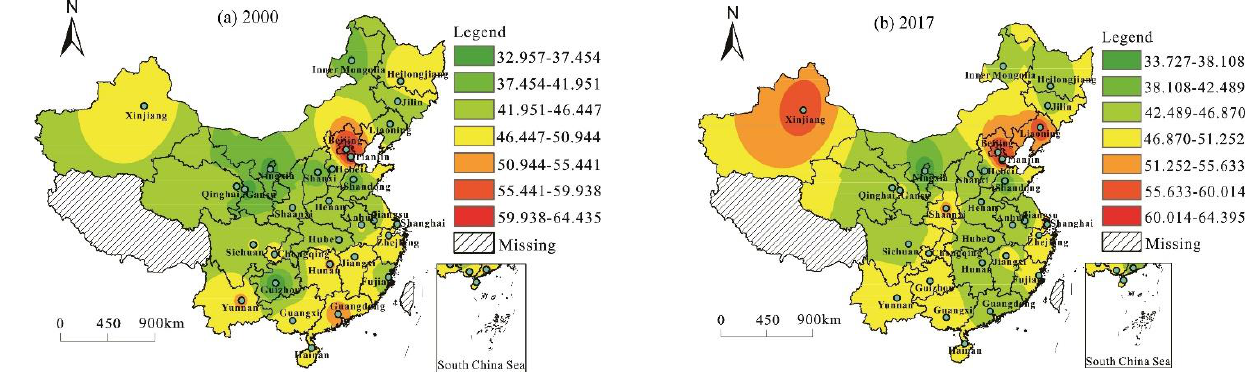
Figure 5. The spatial distribution of closeness centrality in year 2000 ( a ) and 2017 ( b ). (3)